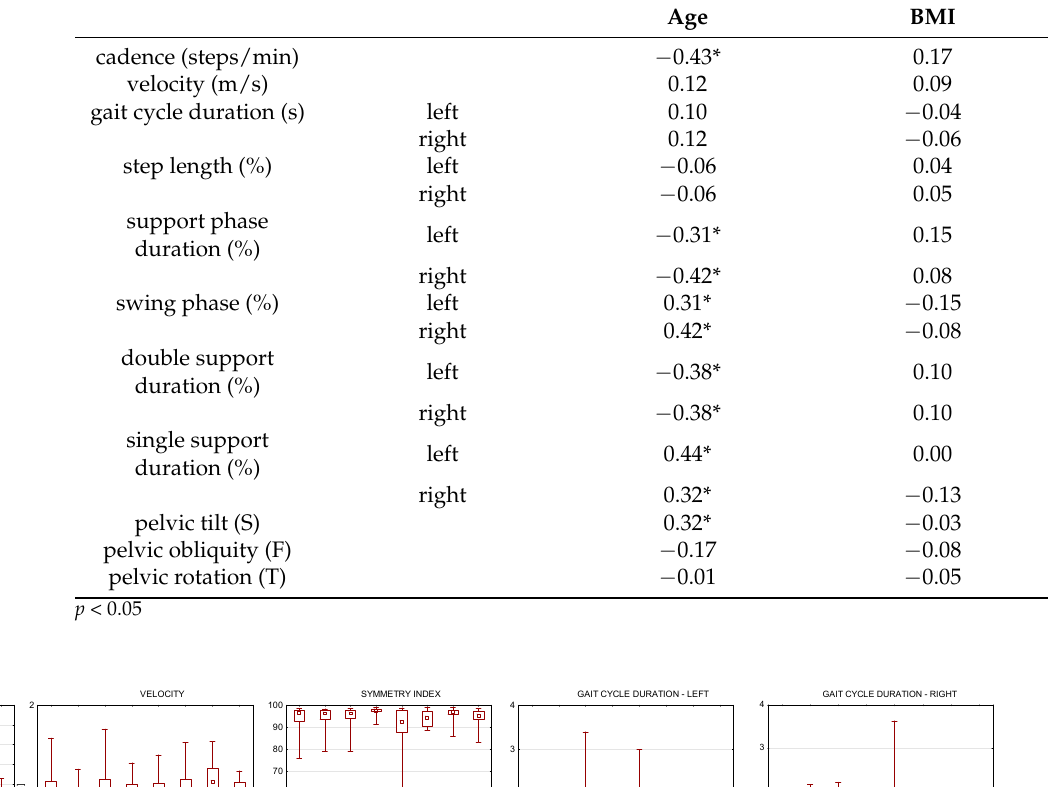
Table 4. Correlation between age, BMI and gait parameters.